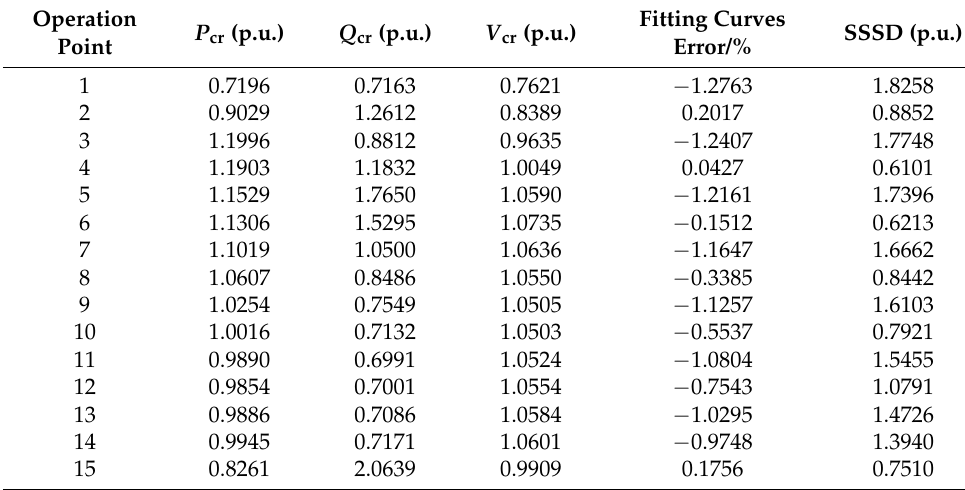
Table 2. Time domain simulation SSSR parameters of wind power unit G DFIG